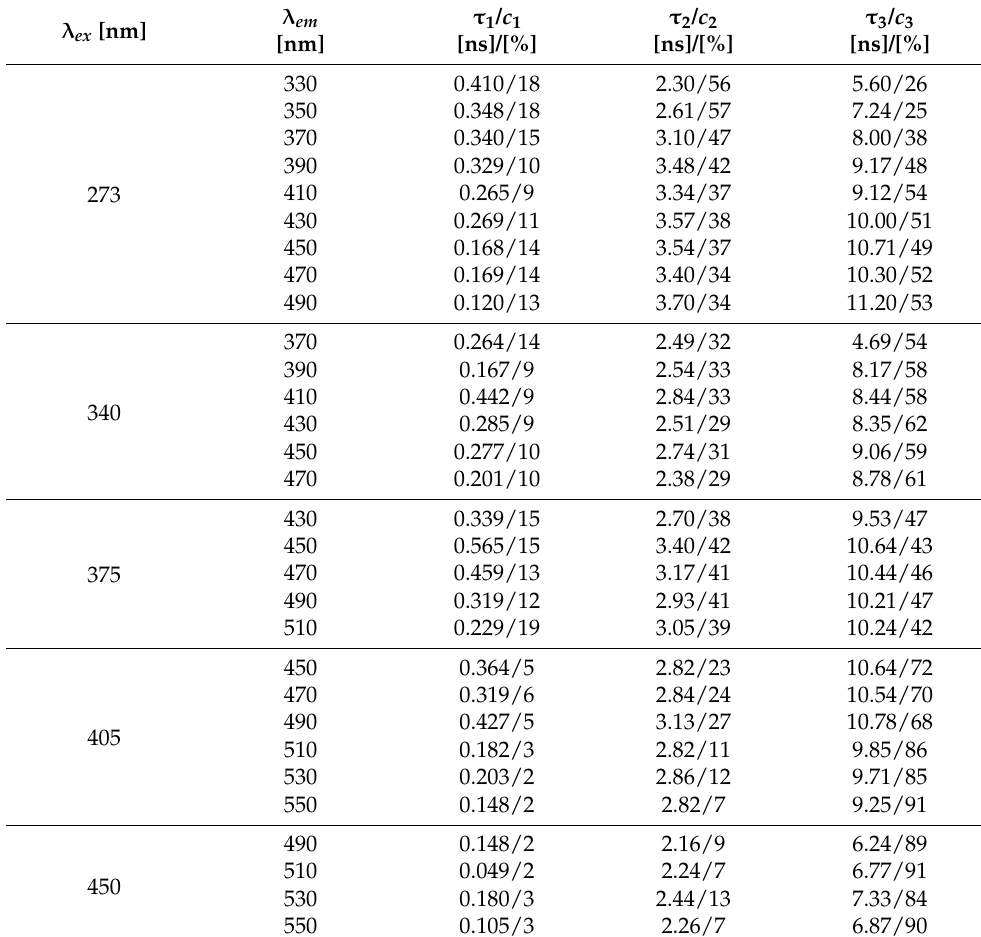
Table 2. Fluorescence decay times { τ i } ( i = 1, 2, 3) and the corresponding percentage contributions { c } ( i = 1, 2, 3) obtained for all autofluorescence decays analyzed (see i